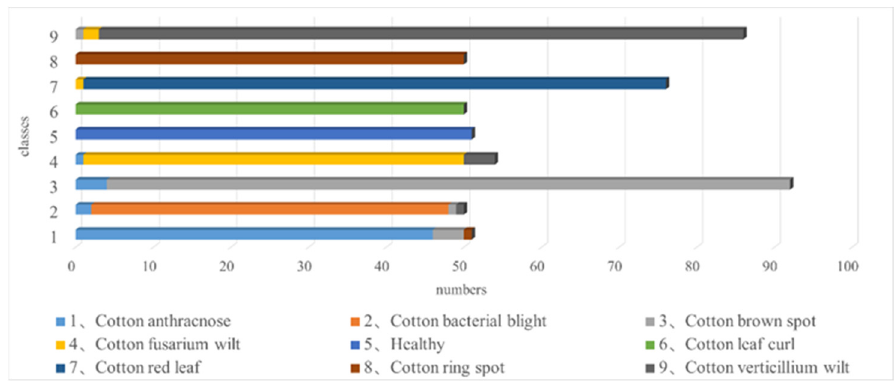
Figure 6. Classification results of the proposed model for nine leaf disease types.